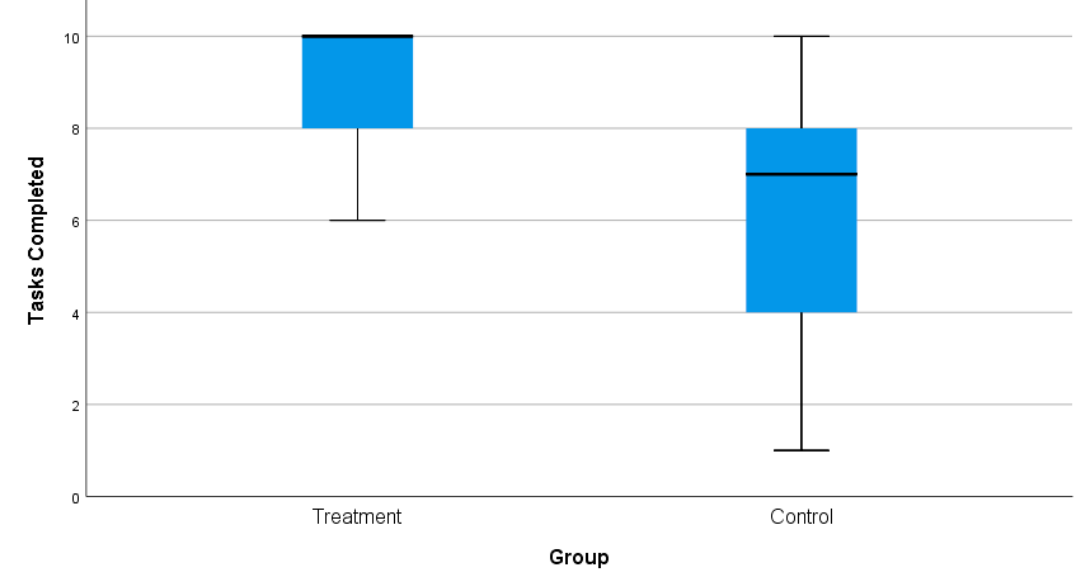
Figure 2. Boxplot of tasks completed.